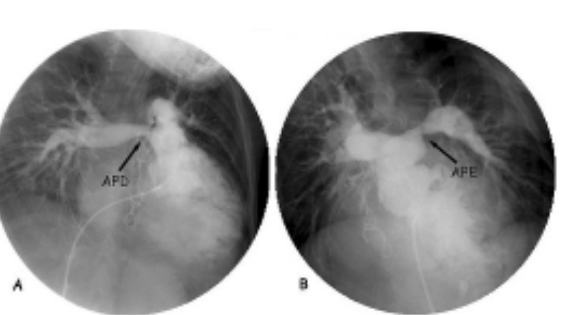
Fig. 1 – Estudo cineangiográfico. A: estenose na origem da artéria pulmonar direita (APD), B: estenose na origem da